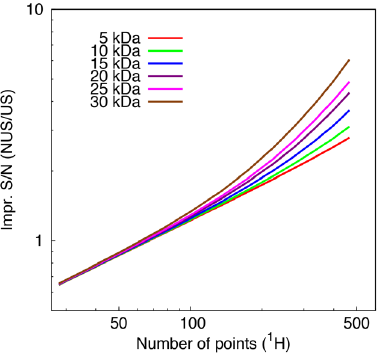
Figure 1. Improvement in signal-to-noise ratio per unit of measurement time by non-uniform sampling. The improvement in S/N ratio in 13 C-resolved NOESY peaks for non-uniformly over uniformly sampled schedules using the parameters in Table S1 is shown for the six proteins with PDB IDs 2BBX (5 kDa), 1D5G (10 kDa), 1XKE (15 kDa), 1JBJ (20 kDa), 1TTE (25 kDa), and 2JT2 (30